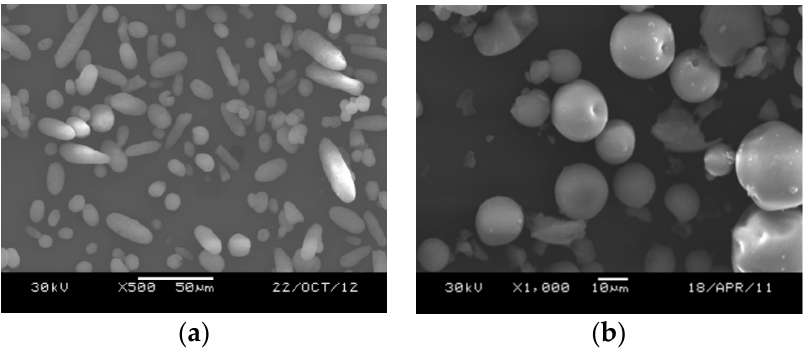
Figure 2. SEM images of the catalyst with different TiCl 4 /toluene molar ratio: ( a ) 1:3; ( b ) 1:1.